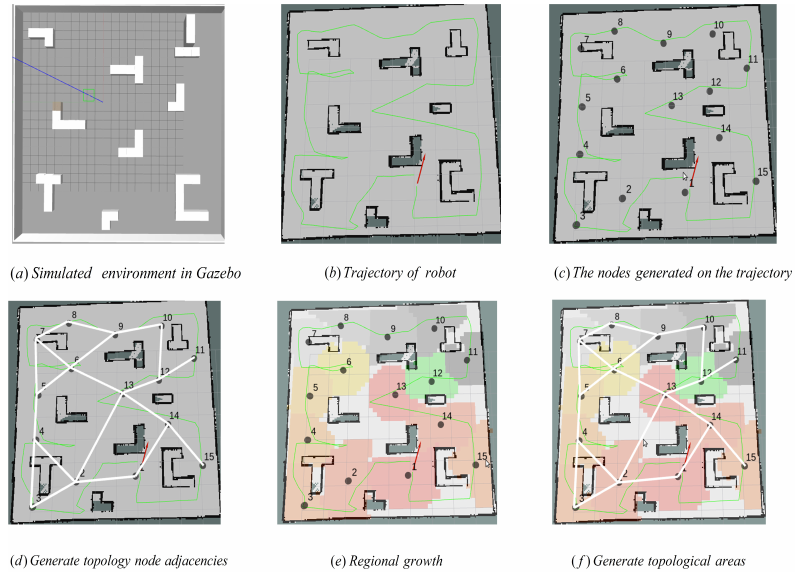
Figure 11. The topological map construction process in a similar environment (basically the same as the process in Figure 3). ( a ) is the simulated environment in Gazebo, ( b ) is the trajectory of robot, ( c ) is the nodes generated on the trajectory, ( d ) is the adjacency, ( e ) is the region dynamic growth algorithm and ( f ) is the Generated topological